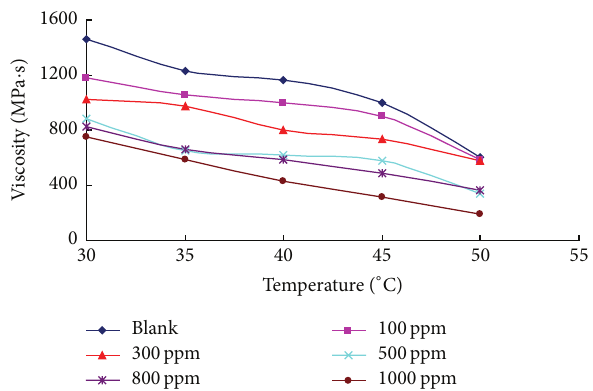
Figure 7: The relation of temperature and viscosity.